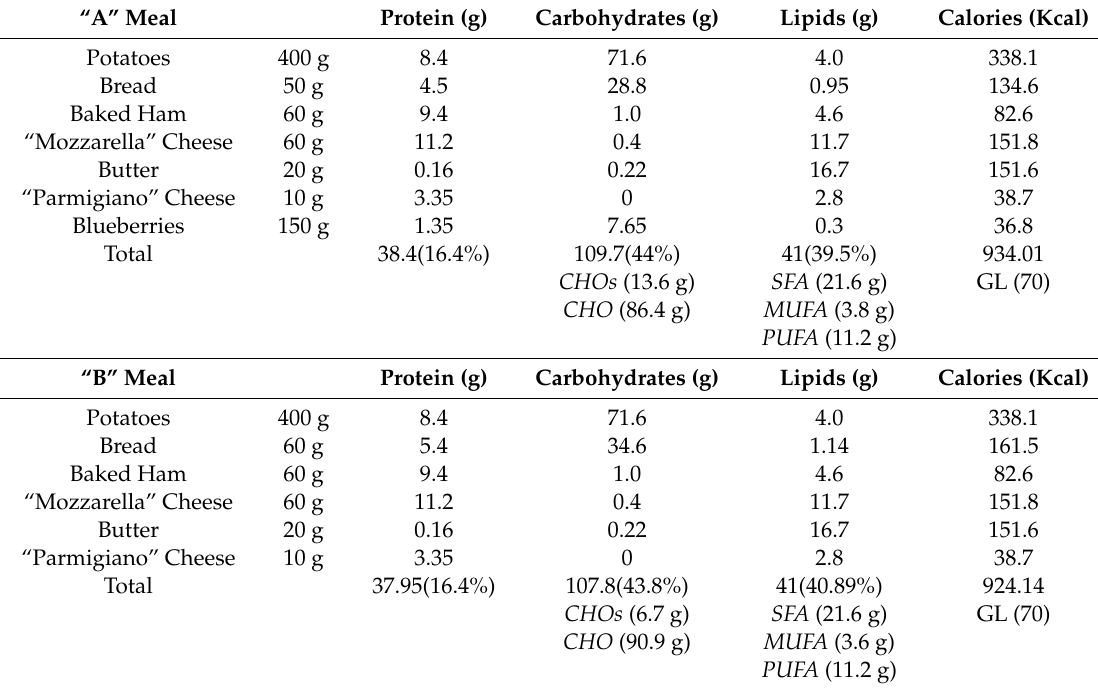
Polyunsaturated Fatty Acid; SFA = Saturated Fatty